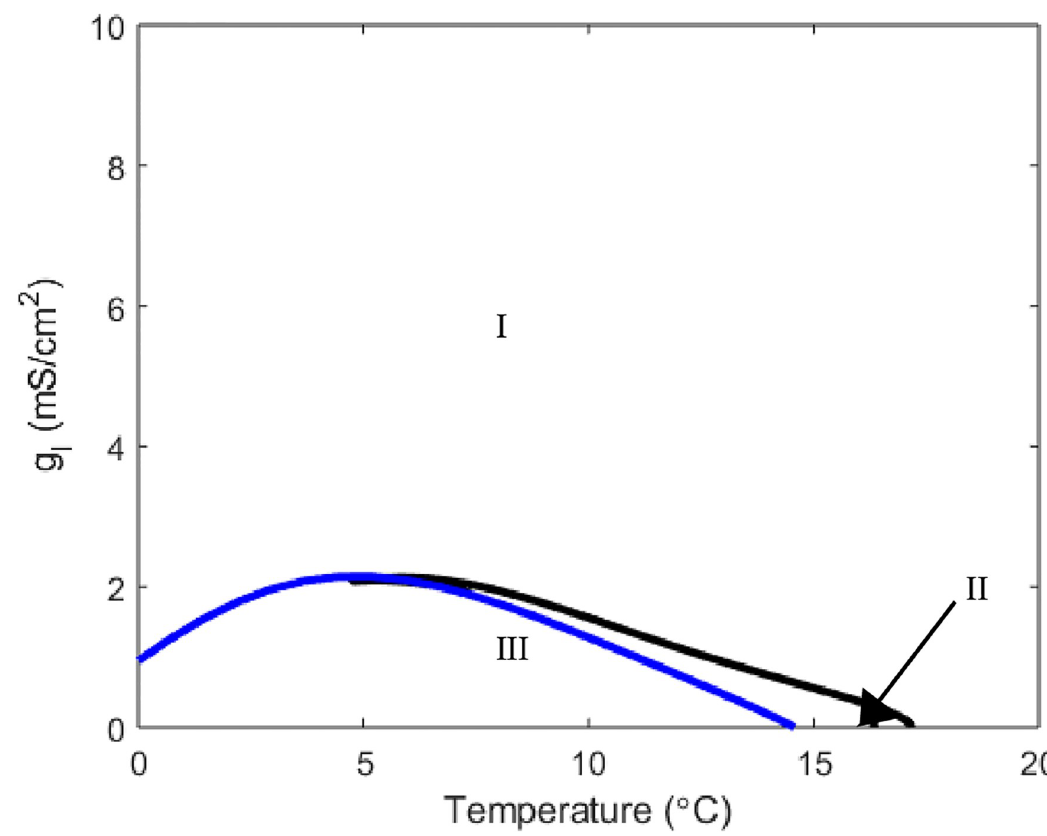
Fig 15. Two parameter bifurcation plot relating g l to temperature. Here g m 8 = 3. All other parameters are set to Hodgkin-Huxley value with curve color and region meaning equivalent to those in Fig 1.